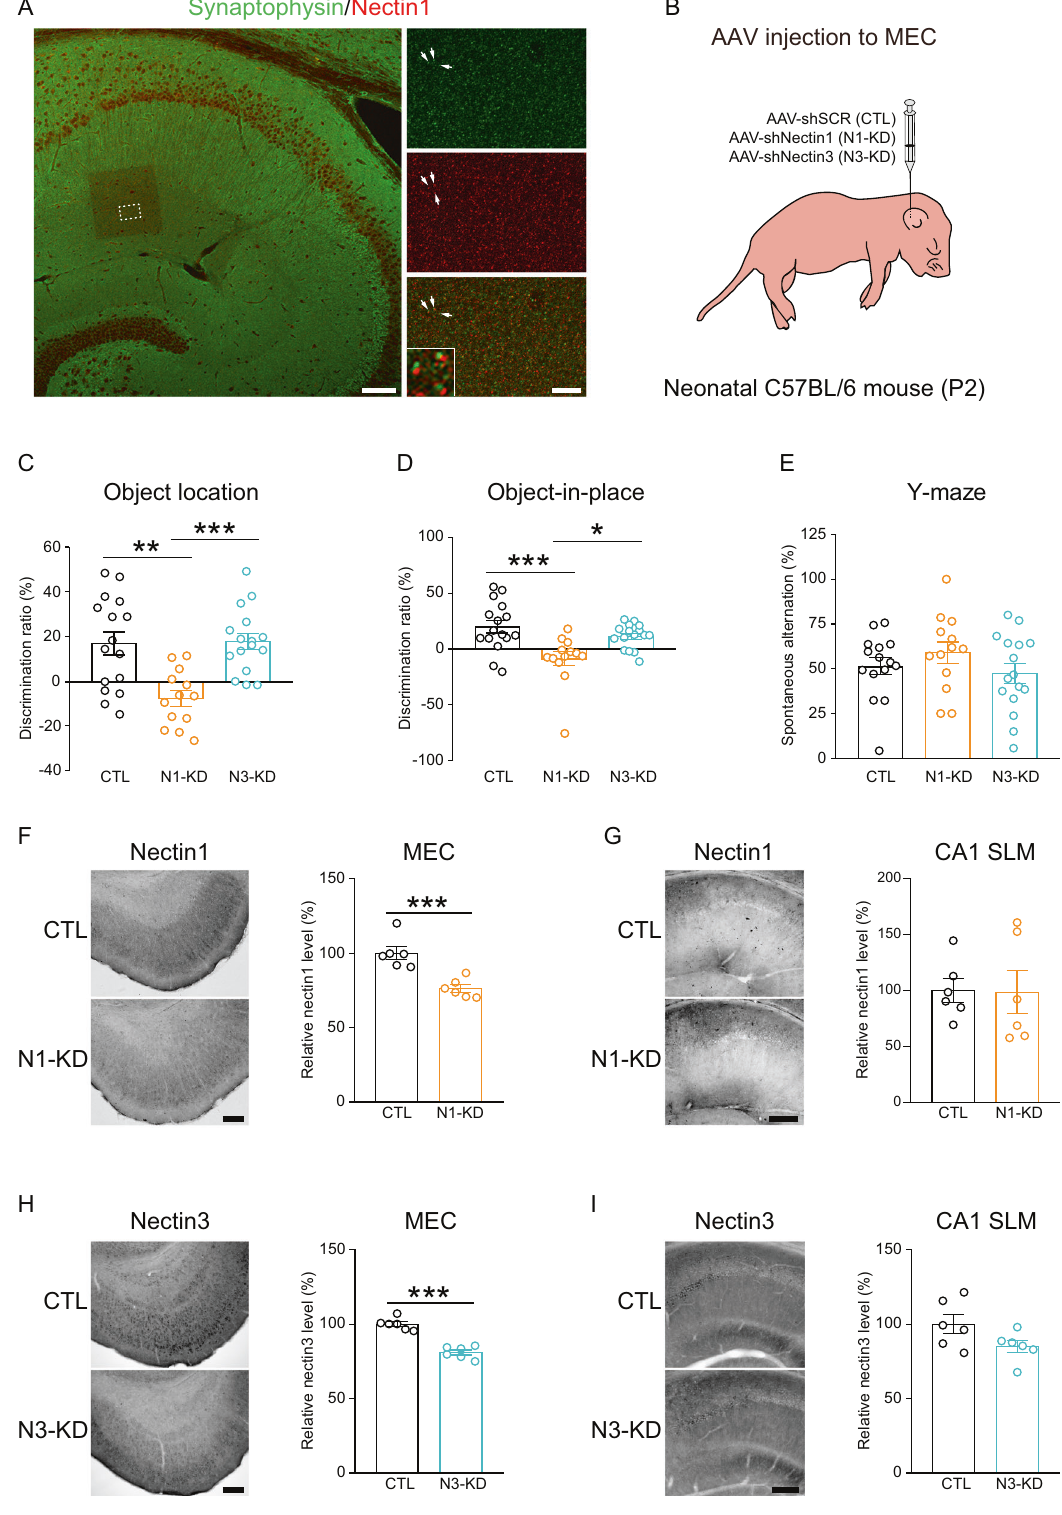
nectin3 suppression on spatial memory performance in adulthood (Fig. 4B). In the object location task, adult mice with postnatal MEC nectin1 knockdown showed impaired object discrimination, indicative of spatial memory impairments (Figs. 4C and S3A). By contrast, mice with suppressed nectin3 level in the MEC had